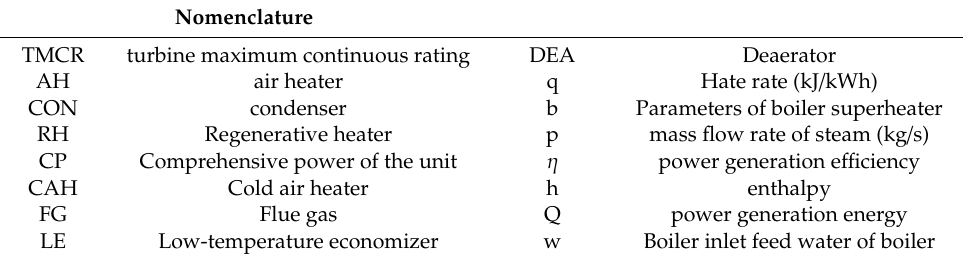
Table 1. Symbols and nomenclature in this